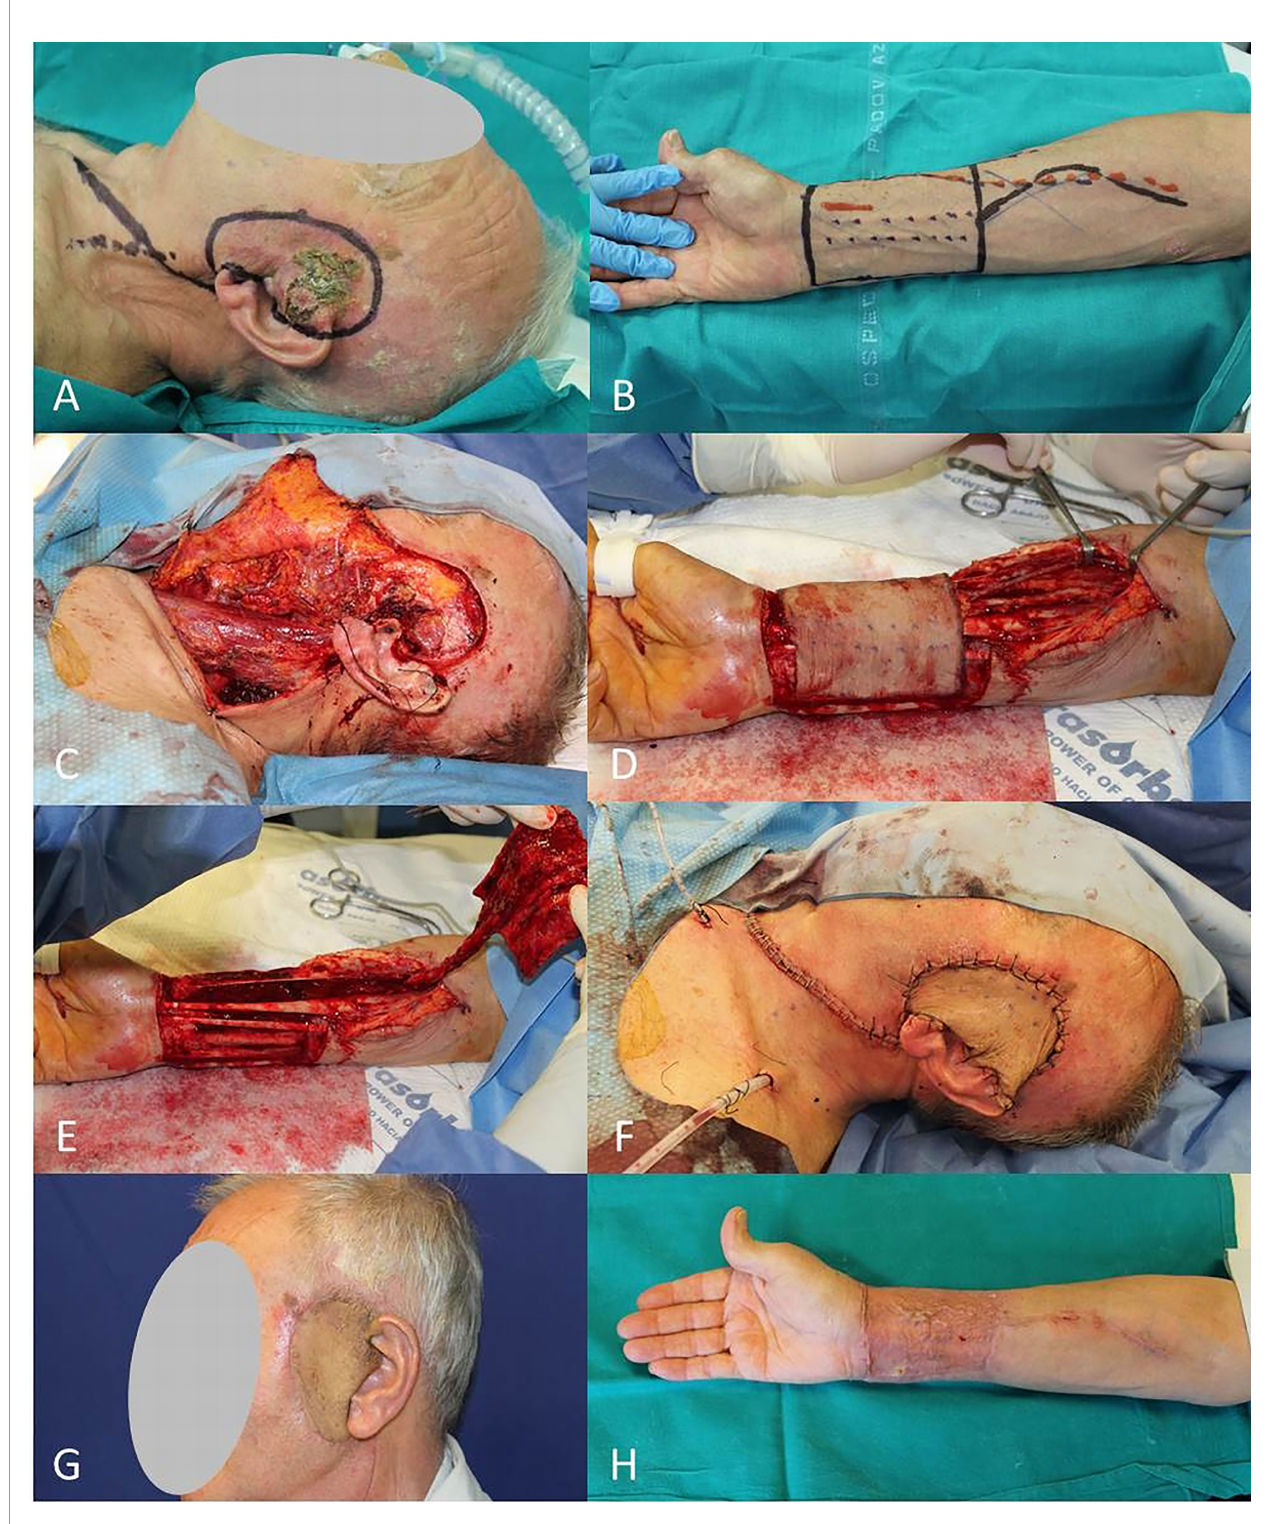
FIGURE 8 | (A) SCC of the preauricolar area; (B) Radial antebrachial free fl ap planning; (C) End of WLE and neck dissection; (D, E) Harvest of radial fl ap; (F) Immediate fi nal result; (G, H) Free radial fl ap and donor site after 2